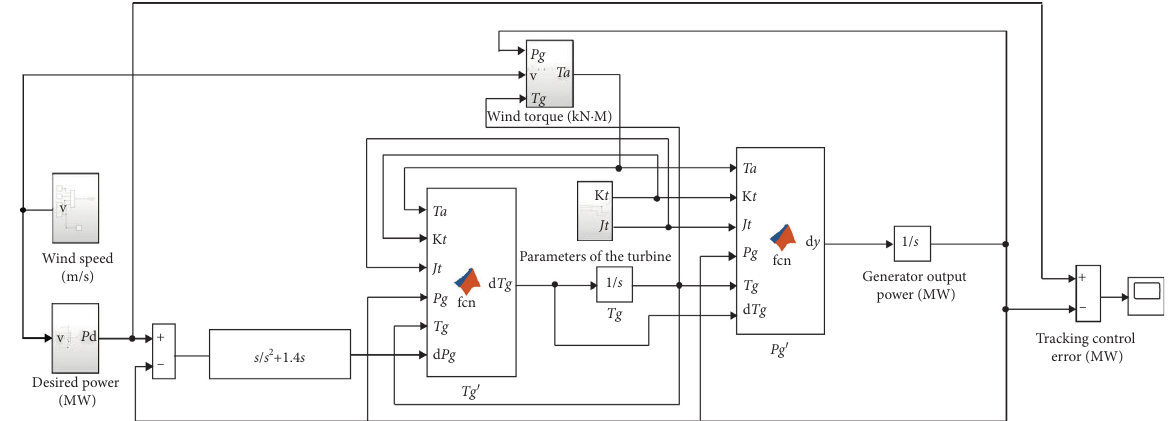
Figure 9: U-control of the wind energy conversion system.